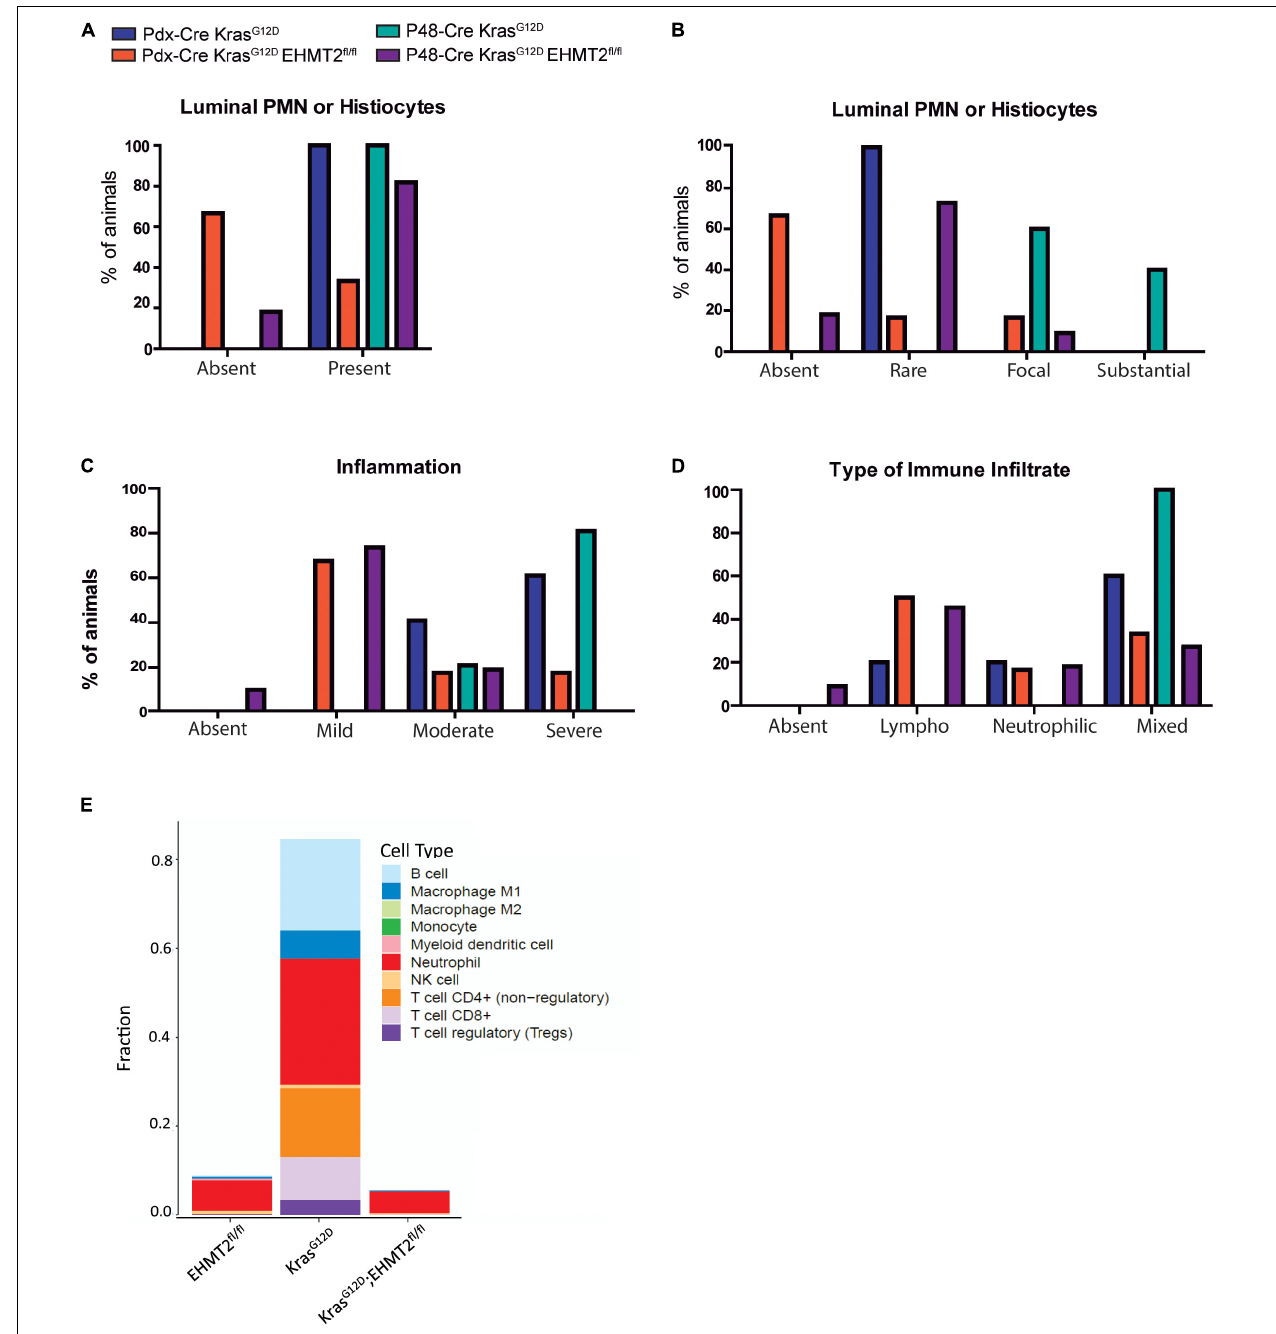
FIGURE 7 | Genetic inactivation of EHMT2 in the mouse pancreas modifies the inflammatory phenotype that characterizes Kras G 12 D -mediated initiation. (A) Graph depicts the presence of polymorphonuclear (PMN) leukocytes or histiocytes in tubular complexes from Kras G 12 D ;EHMT2 + / + and Kras G 12 D ;EHMT2 fl / fl animals driven by Pdx1-Cre ( n = 5 or 6, respectively) or P48 Cre / + ( n = 5 or 11, respectively). (B) The extent of PMN or histiocyte luminal infiltration was scored as absent, rare, focal or substantial. Kras G 12 D animals with EHMT2 inactivation showed reduced infiltration of these cells for both backgrounds ( Pdx1-Cre and P48 Cre / + ). (C) The degree of inflammation in tubular complexes was classified as absent, mild, moderate or severe. While Kras G 12 D mice predominantly presented with moderate to severe inflammation, the majority of Kras G 12 D ;EHMT2 fl / fl animals only showed mild inflammation. (D) The type of inflammatory cells infiltrating these precursor lesions was evaluated and classified as absent, lymphoplasmacytic (Lympho), neutrophilic or mixed. While Kras G 12 D animals mostly presented with a mixed inflammatory infiltrate, Kras G 12 D ;EHMT2 fl / fl mice predominantly demonstrated lymphoplasmacytic infiltrate. (E) Immune cell type profiling demonstrates the percentage of infiltrating immune cell types obtained by quanTIseq analysis of DEG from Pdx1-Cre;EHMT2 fl / fl , Pdx1-Cre;LSL-Kras G 12 D ;EHMT2 + / + , and Pdx1-Cre;LSL-Kras G 12 D ;EHMT2 fl / fl mice. Scores representing the absolute fractions of immune cells reveal that there is enrichment of T cells, neutrophils, M1-type macrophages and B cells in Kras G 12 D animals, which is not present in mice with EHMT2 inactivation.